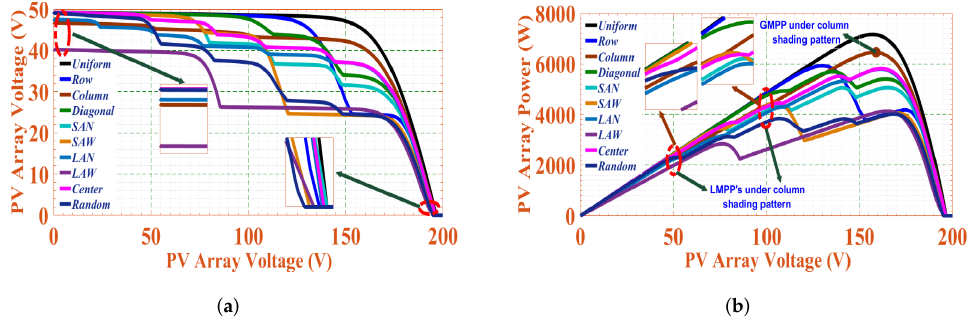
Figure 8. Results of S-P-C-T topology under various PSCs. ( a ) I-V characteristics, and ( b ) P-V character-